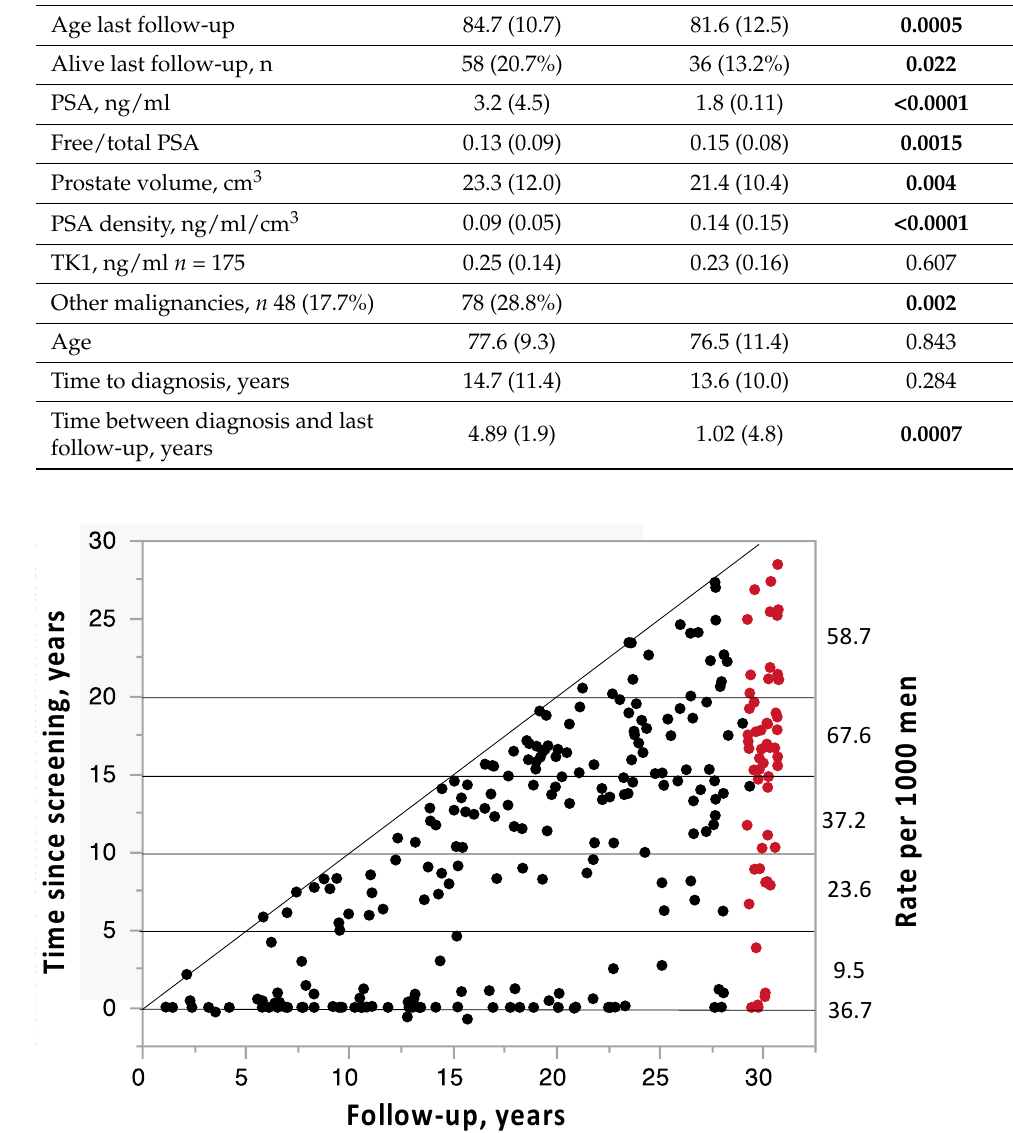
Figure 2. Last follow-up in relation to the time of the diagnosis in 271 men with prostate cancer, detected by screening 1988/89 and during 30 years of follow-up. Red symbols: alive, black symbols: deceased. On the right side, number of prostate cancers in relation to the actual number of the initial 1782 men.